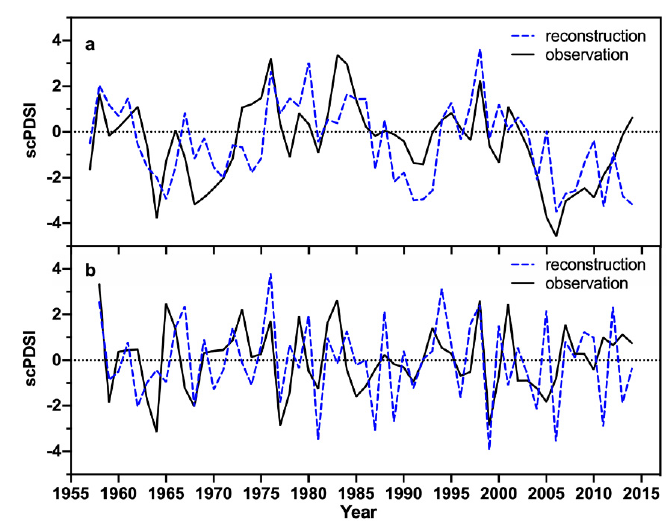
\* MERGEFORMAT } 2014 (Figure 7a). The positive RE and CE statistics in the split period calibration/verification tests indicates good model skills (Table 2). A positive reduction of error (RE = 0.23) generated from the LOOCV test suggests that the reconstruction model is reliable. The first-differenced reconstructed and observed data were compared during their common period (Figure 7b). The correlation coefficient (r = 0.33, p < 0.05) and F value (F = 6.66, p < 0.05) are both statistically significant. These statistics together suggest that the robustness of the pMay–cApr scPDSI reconstruction. Table 2. Statistics of split calibration verification test results for the common period 1957–2014 CE. Calibration